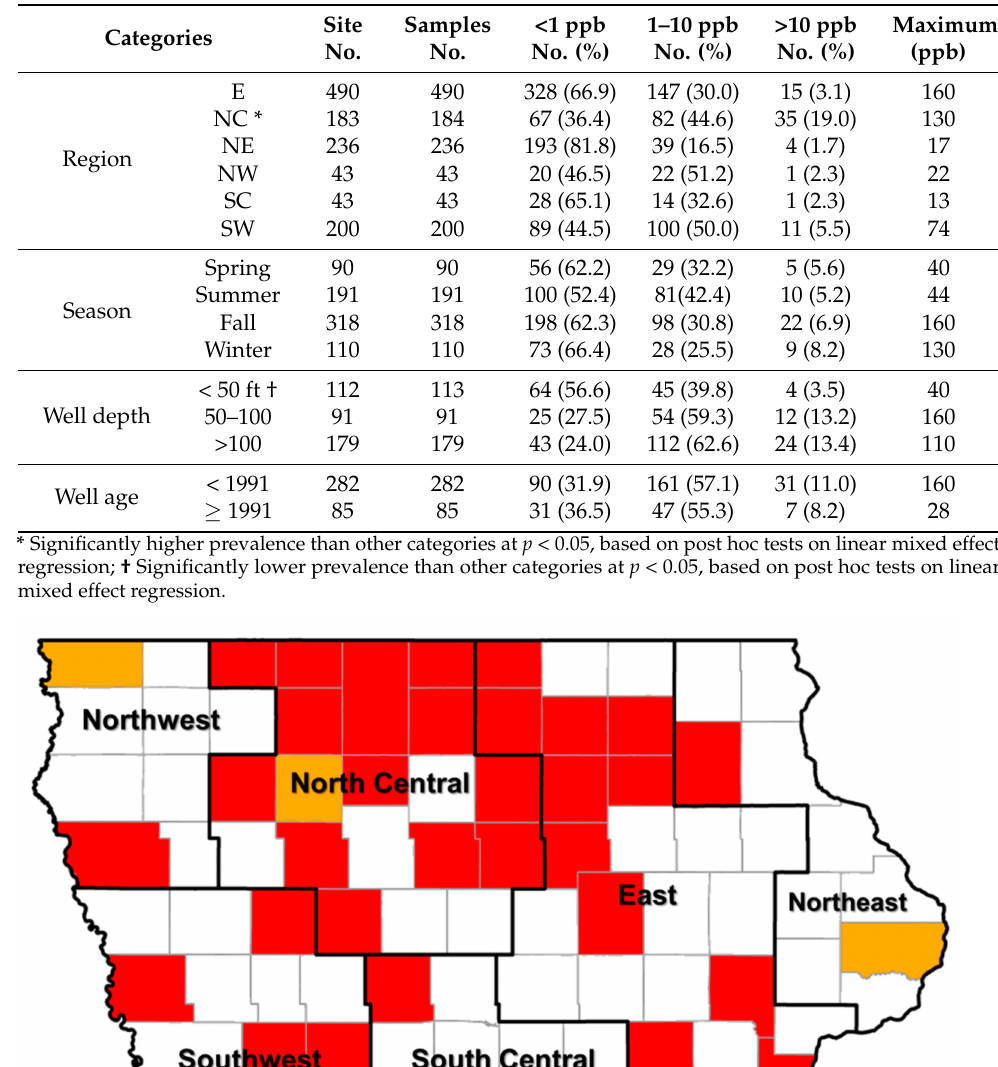
Table 3. Occurrence of Arsenic in Private Wells (Drinking Water MCL = 10 ppb).